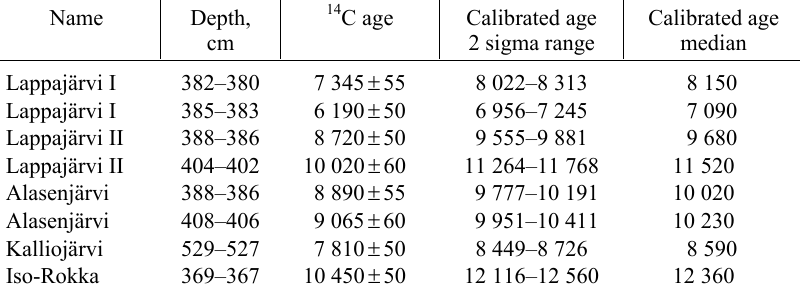
Table 2. AMS radiocarbon dates. All dates are prepared from bulk gyttja sediment